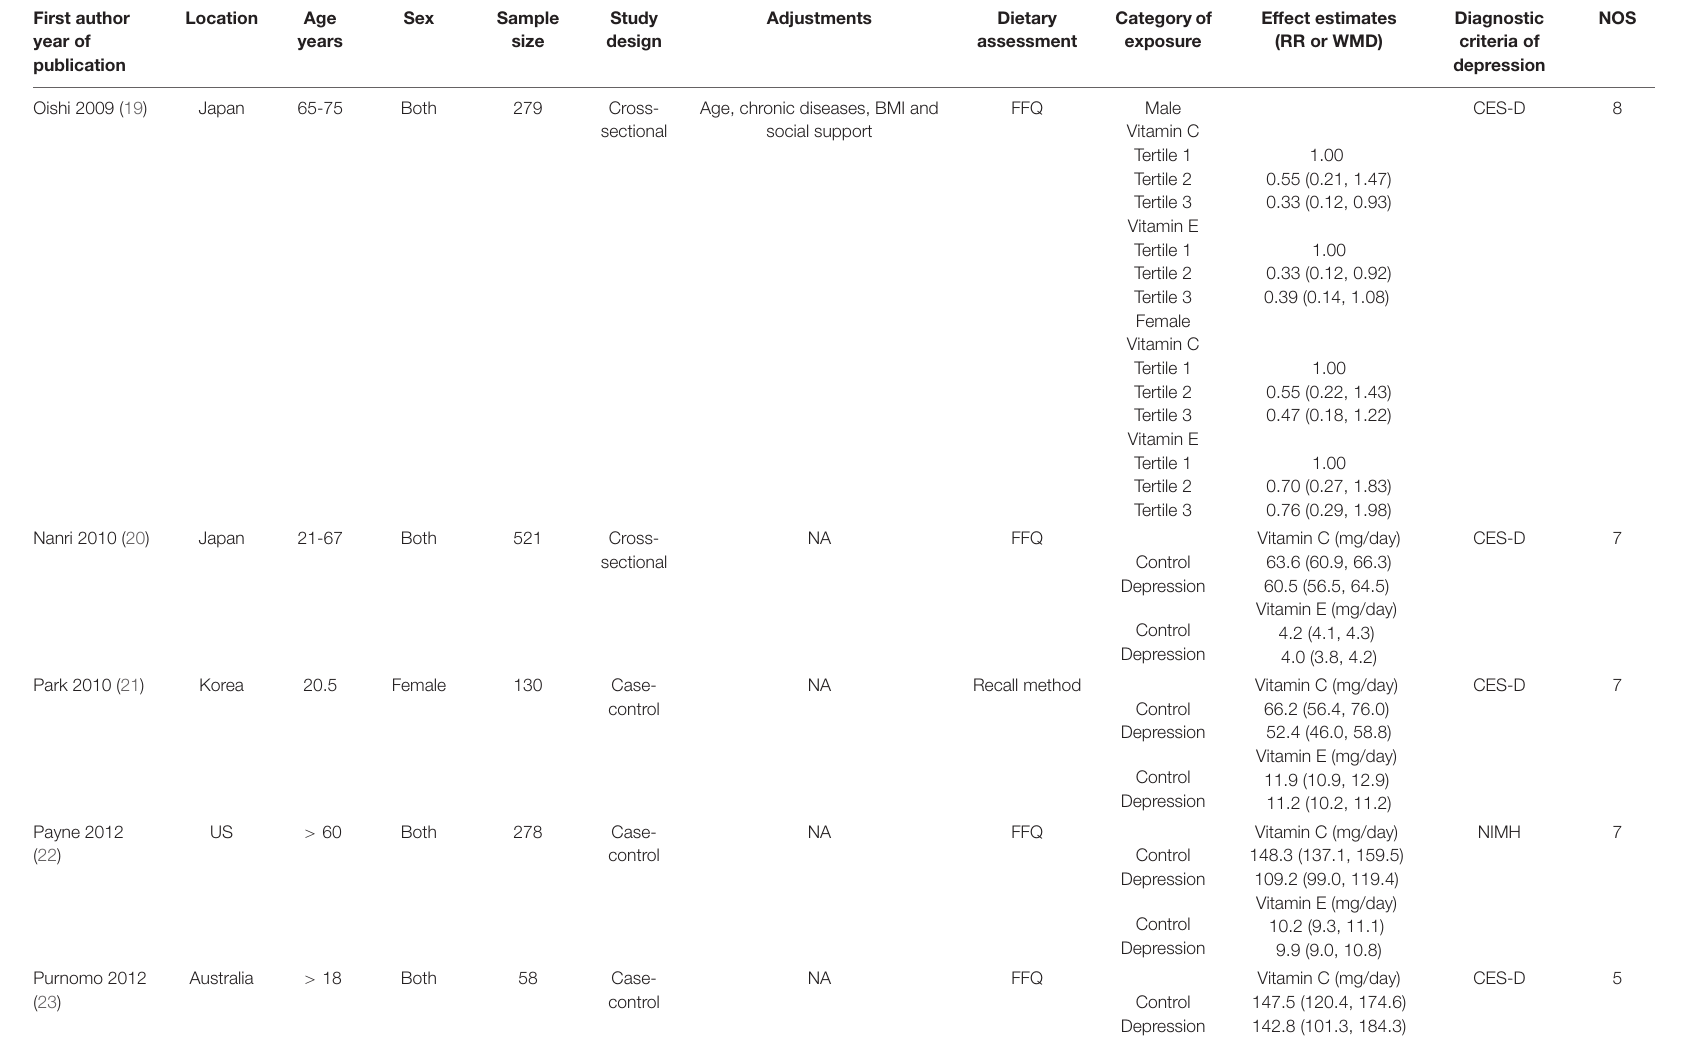
TABLE 1 | Characteristics of the individual studies included in this